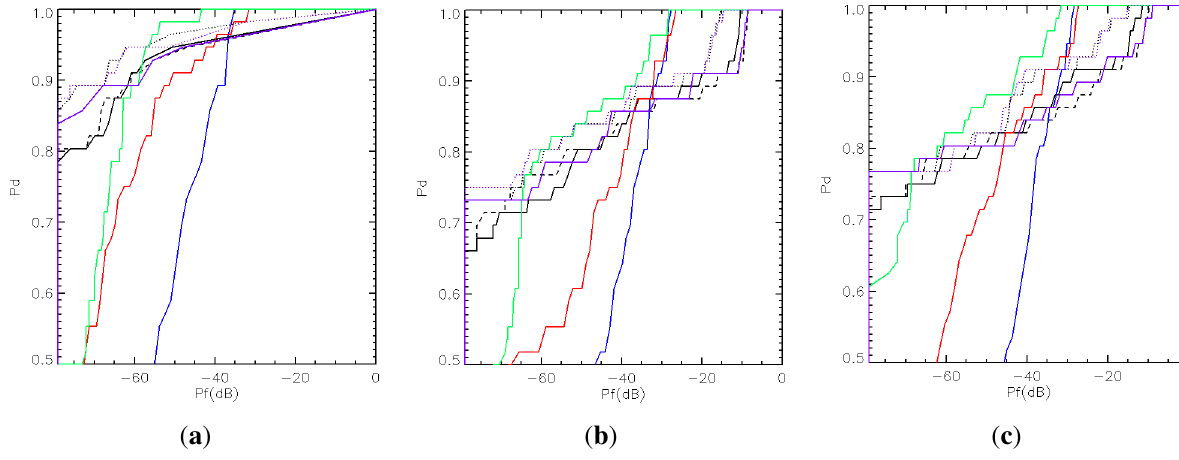
Figure 7. Detector ROC curves for sub-look analysis in the azimuth direction. RADARSAT-2 fine quad-pol data. Boxcar filter: 3 × 5 (range × azimuth) pixels. ( a ) HV channel; ( b ) HH channel; ( c ) VV channel. Vessels analyzed: 69; pixels used for P ∼ 10 − 7 . Black: sub-look correlation (solid: filtered with no overlap; dashed: filtered 30% overlap); blue: sub-look coherence; green: GLRT; violet: intensity (dotted: no average; solid: averaged); red: sub-look